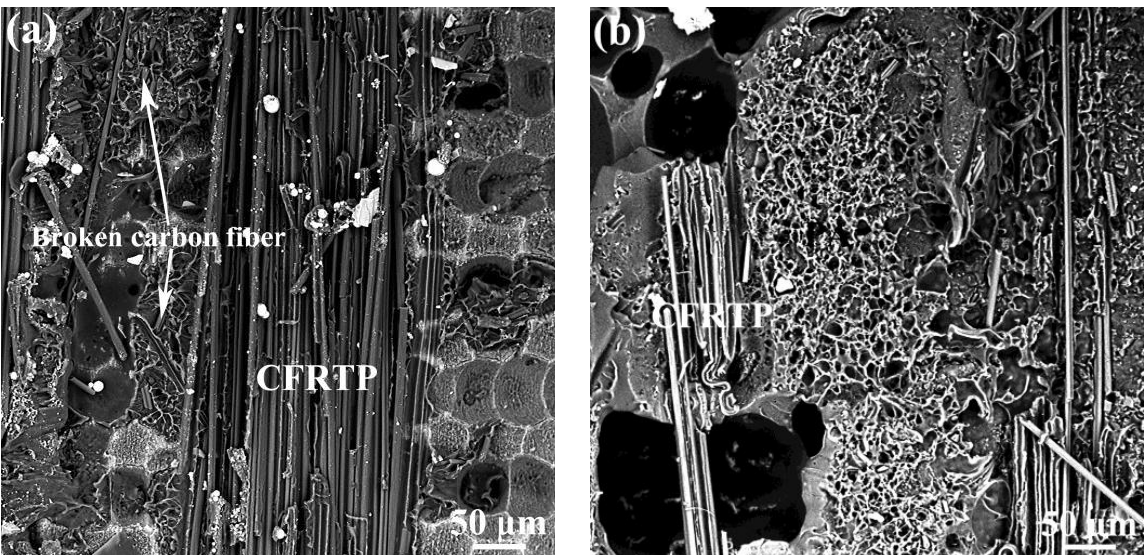
Figure 13. Fracture surface of the Al/CFRTP butt joints with Al joining interface pretreated by different hybrid pretreatments: ( a ) micro-texturing and subsequent anodizing and ( b ) Anodizing and subsequent micro-texturing.